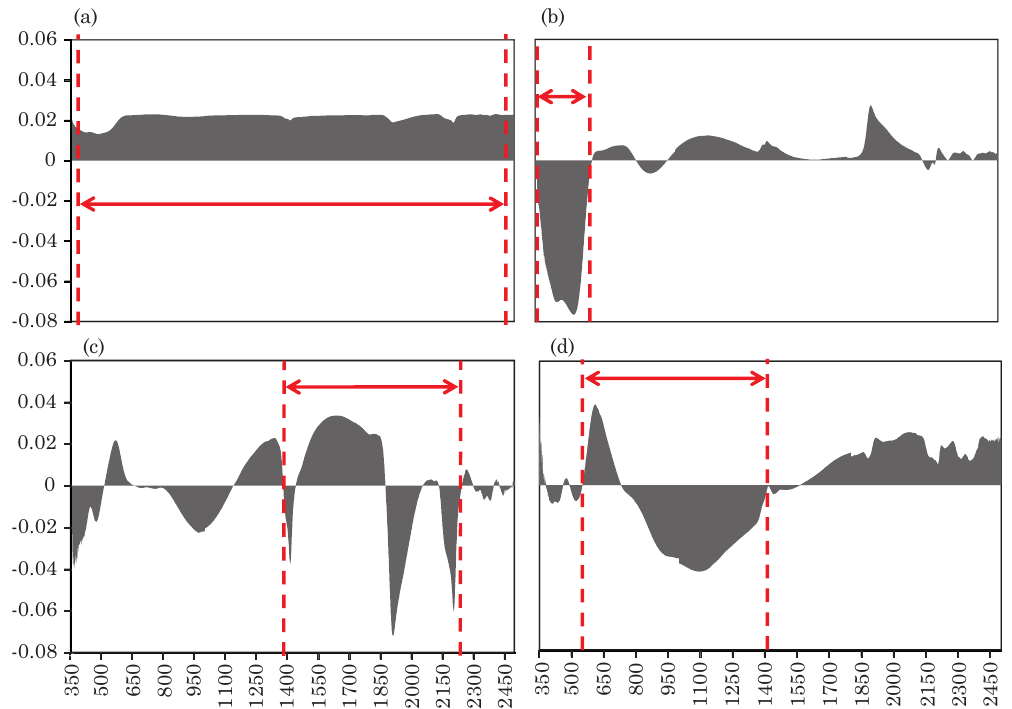
Figure 3. PCA loadings of the (a) first principal component - PC1, (b) second principal component - PC2, (c) third principal component - PC3, and (d) fourth principal component -